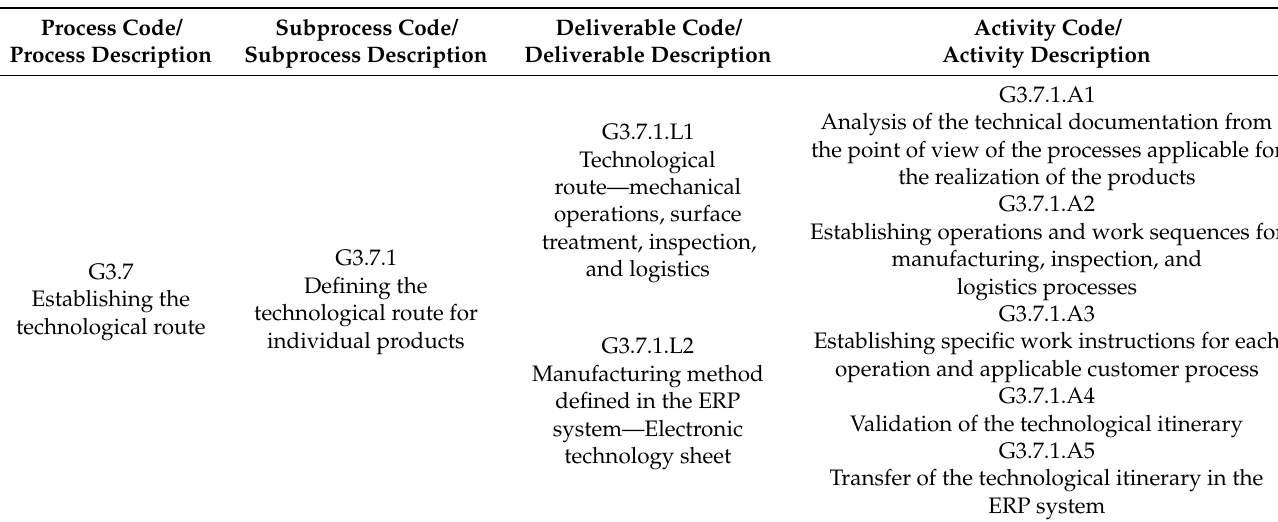
Table 4. Description of the activities of process groups G3.7 and